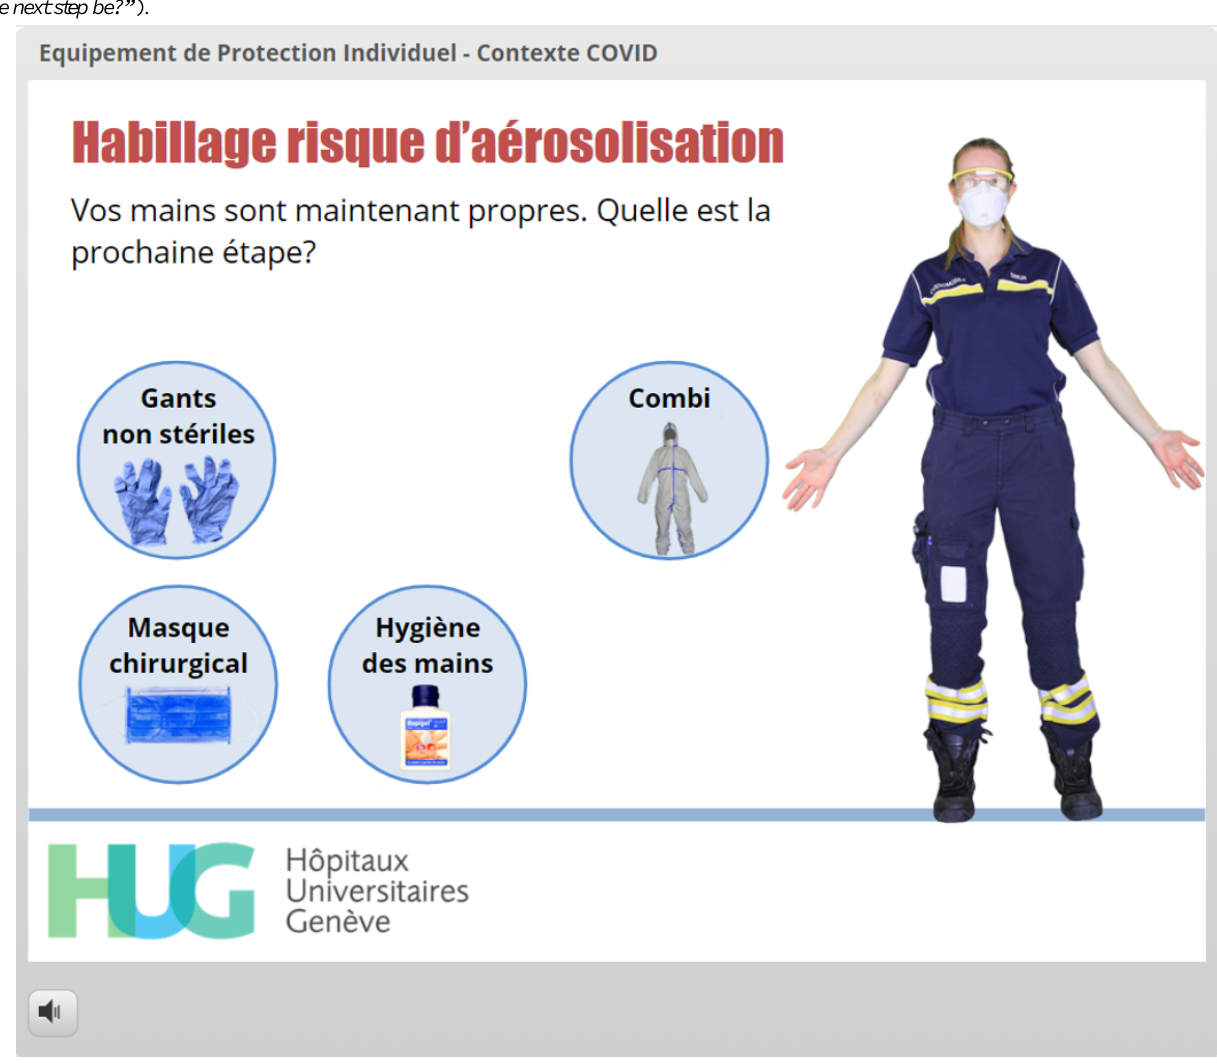
Figure 9. Use of gamification to facilitate acquisition of the correct sequence of donning PPE before high-risk procedures such as endotracheal intubation. The user has already correctly used the FFP2 respiratory mask and protective goggles and has proceeded with hand hygiene. The feedback is displayed at the top of the screen ( “Vos mains sont maintenant propres. Quelle est la prochaine étape?” which means “Your hands are now clean. What should the next step be?”